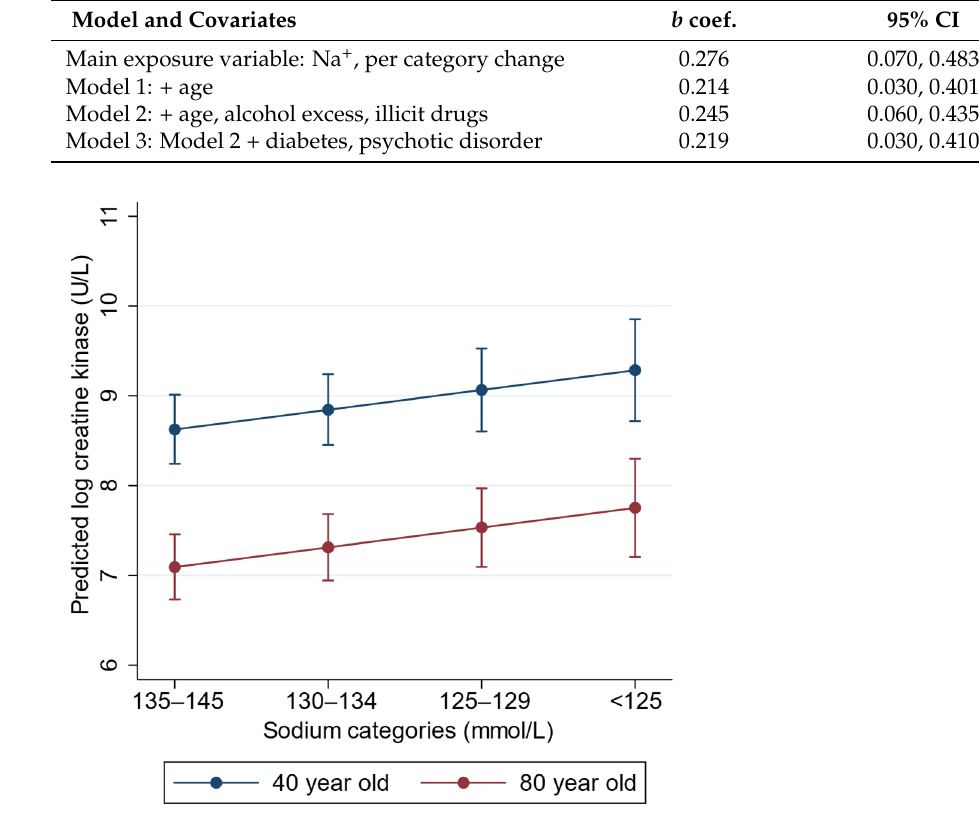
Figure 5. Predicted creatine kinase from regression model with adjusted means and 95% confidence intervals, showing higher creatine kinase with increasing hyponatremia severity. Creatine kinase was lower in elderly patients at the same level as the other covariates.